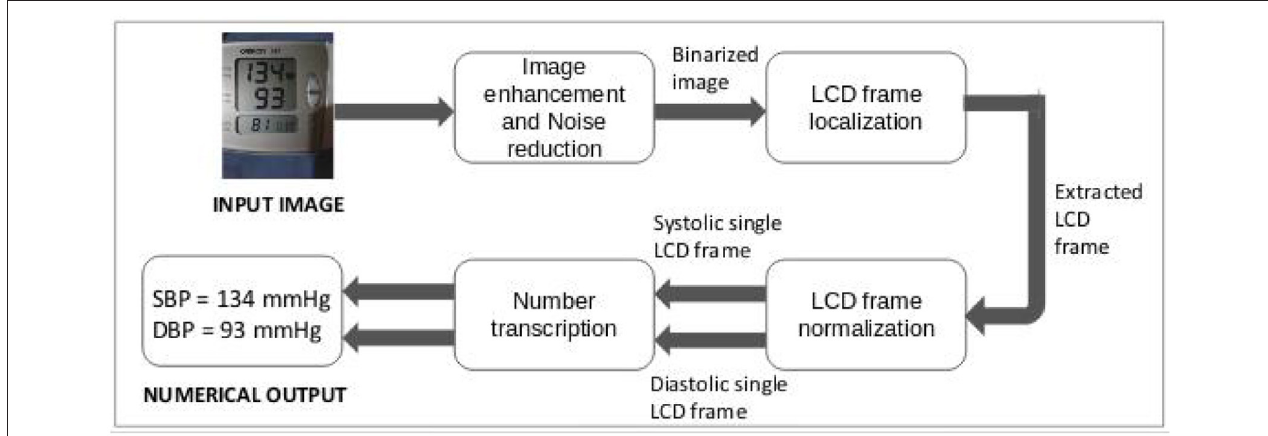
FIGURE 3 | Design of proposed optical character recognition (OCR) approach to digitize blood pressure readings.